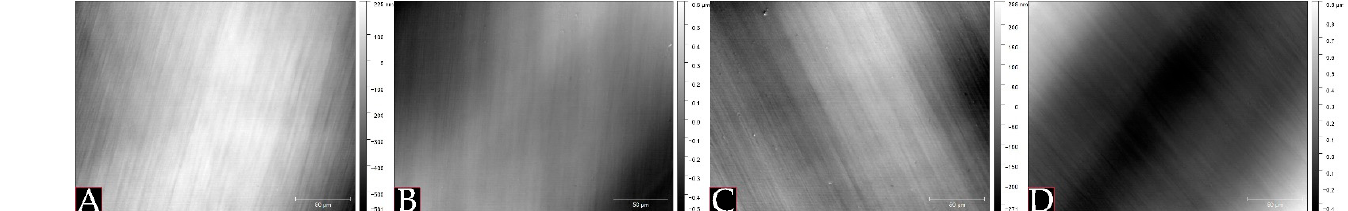
Figure 3. Profilometry images for both materials included in the study based on the location: ( A ) ZrO-HT centre, ( B ) ZrO-HT periphery, ( C ) ZrO-UTML centre, ( D ) ZrO-UTML periphery.